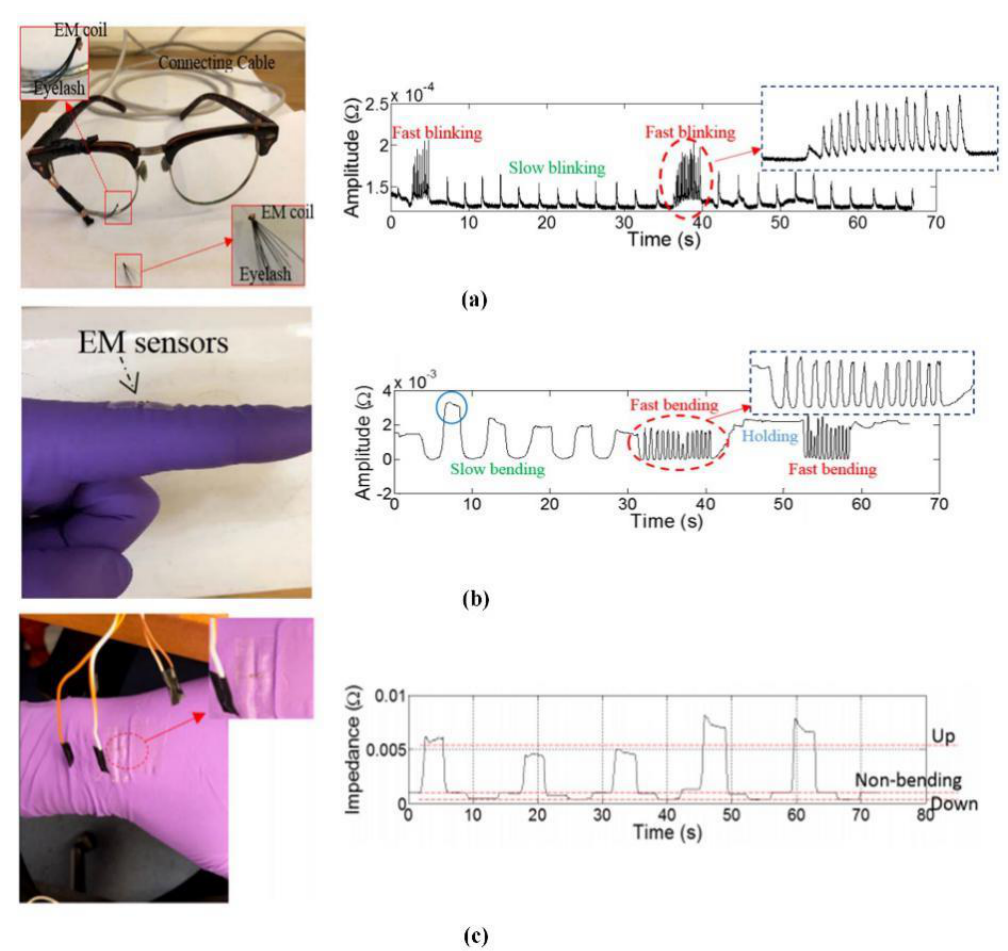
Figure 14. The biomechanical motion monitoring based on electromagnetic biosensors. ( a ) Wearable EM sensor. ( b ) Finger bending. ( c ) Wrist bending. Adapted with permission from ref. [108]. Copyright 2020 IEEE.